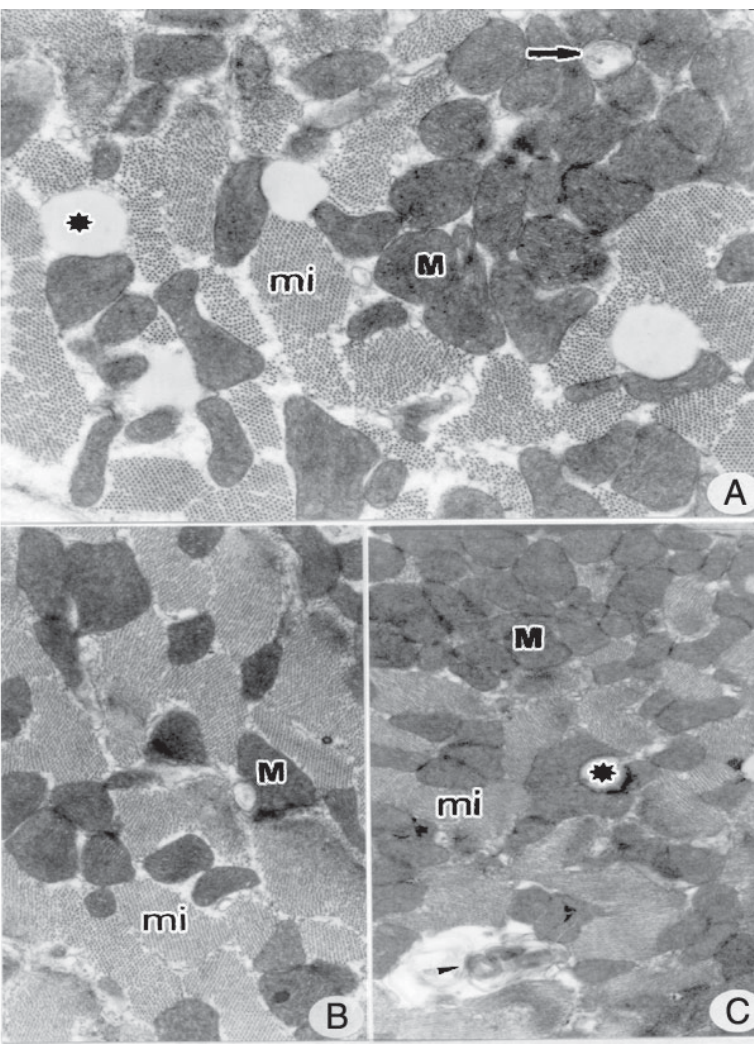
Figure 1. Cardiac striated muscle from the group receiving a UFA-rich diet. A , B and C = Myofibrils (mi). Normal mitochondria (M). Mitochondria with loss of cristae in A (arrow). Lipid vesicles in A and C (*). Myeloid bodies in C (arrowhead). A: 4600X; B: 3400X; C: